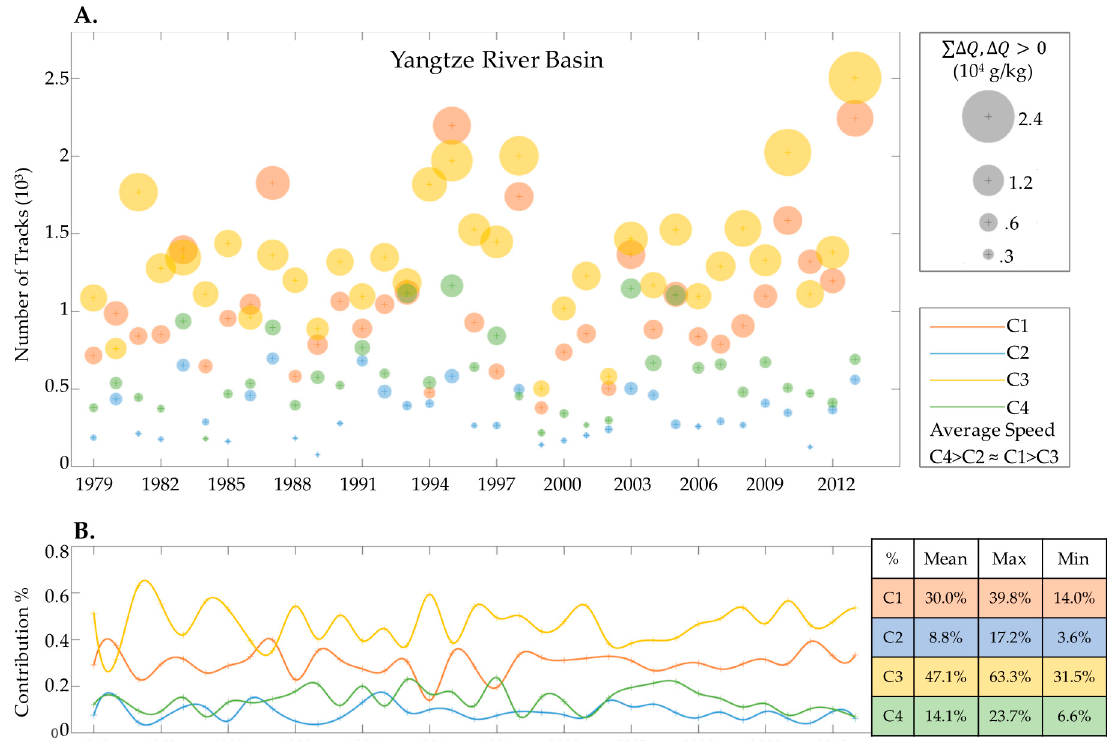
Figure 5. Contributing number of TMEs tracks and the associated moisture release from each Cluster for the Yangtze river basin. ( A ) the colors of the circles are consistent with the clusters in Figure 4. The center of the colored circle shows the total number of tracks (vertical axis) from the identified source to the basin for each year (bottom axis). The size of the circle represents the total amount of moisture release of those tracks. The size is proportional to ( ∑∆ Q ) 1.5 . The scale reference of the circle is the panel on the right. The order of the clusters’ traveling speeds is given for fast reference to Figure 4B. ( B ) the colored lines show the smoothed time series of the annual contribution of each Cluster in terms of moisture release. The contribution is calculated as the percentage of the total. The summary statistics of their contributions (mean, maximum and minimum values) are tabulated in the colored table. The colors of the clusters are consistent over the entire paper.